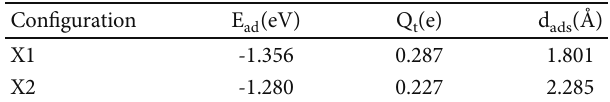
and N O adsorbed on Ga-Graphene ((a) X1 top view; (b) X1 side view; (c) X2 top 3 2 Table 4: The E , Q , and structural parameters of the NF ad t O adsorbed on N 2